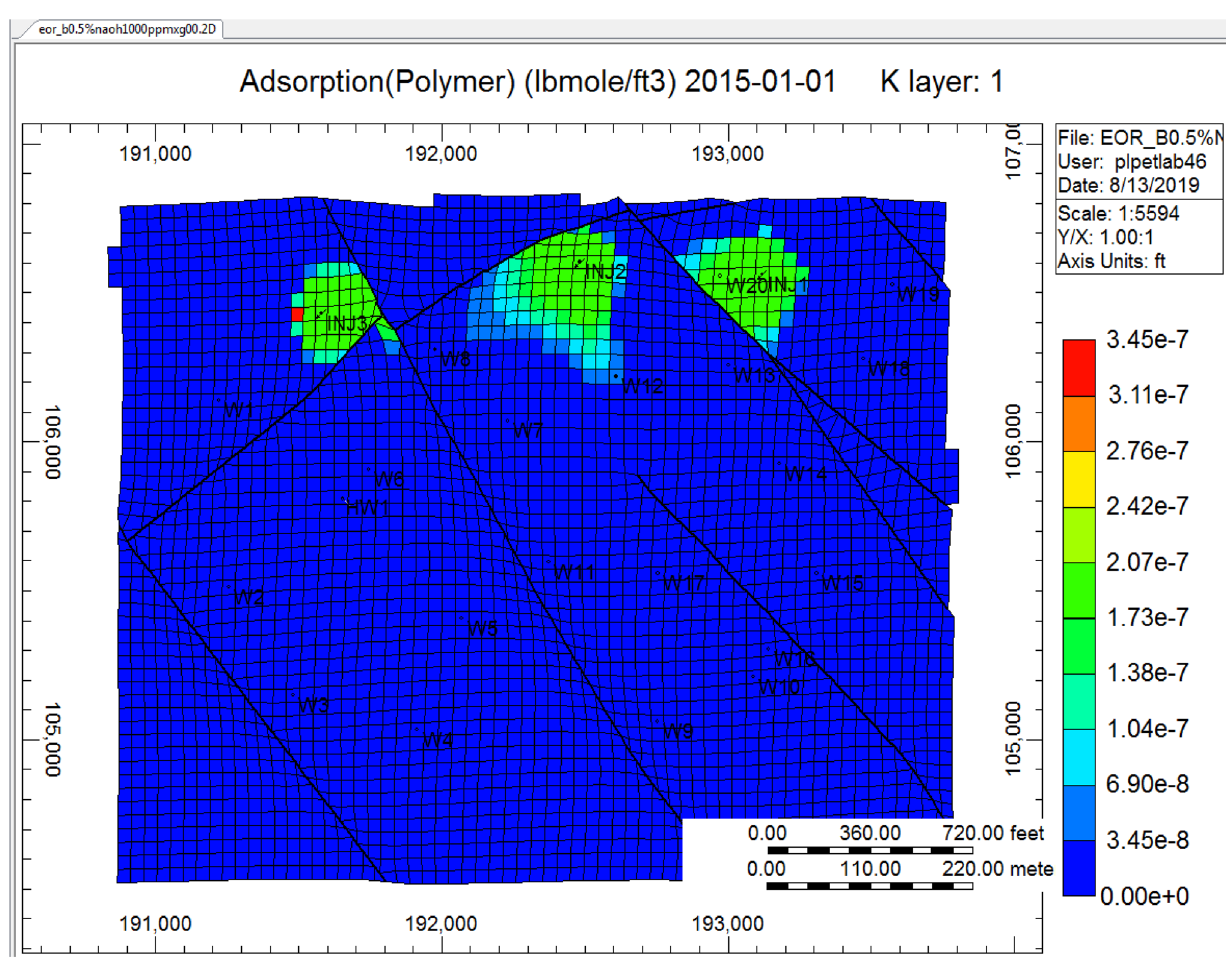
Fig. 13 Adsorption of 1000 ppm Polymer with 0.5%